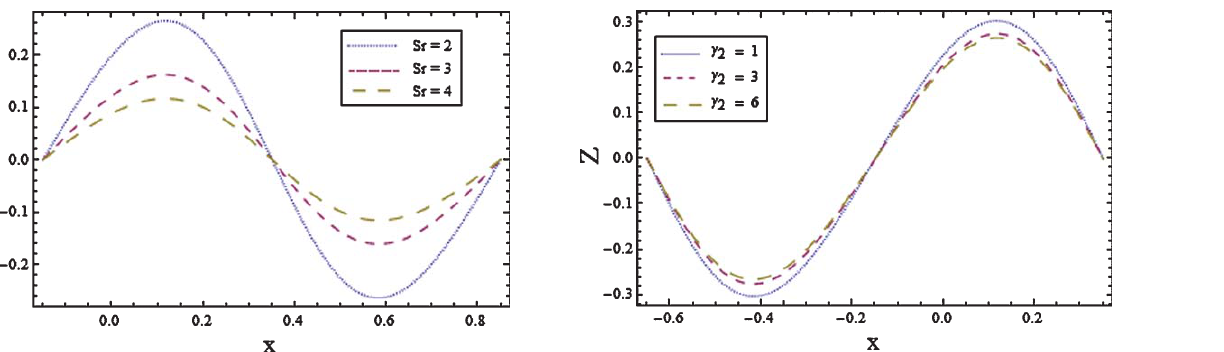
Fig. 20. Plot of heat transfer coefficient Z for various values of the Biot number γ 2 with (cid:15) = 0 . 1, t = 0 . 1 , Sc = 1 , Du = 2 , Sr = 2 , γ = 1 , Pr = 1 . 5 and γ = 10. 1